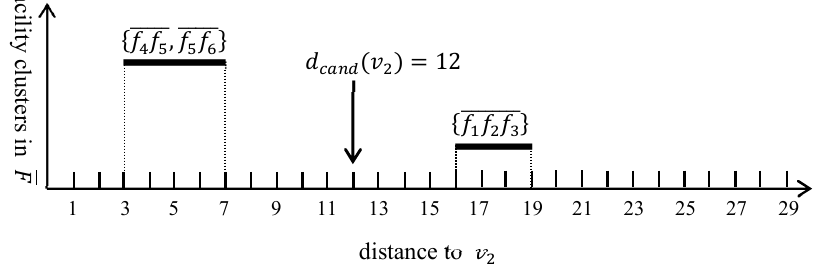
Figure 11. Arrangement of the facility clusters based on their largest distance to v 2